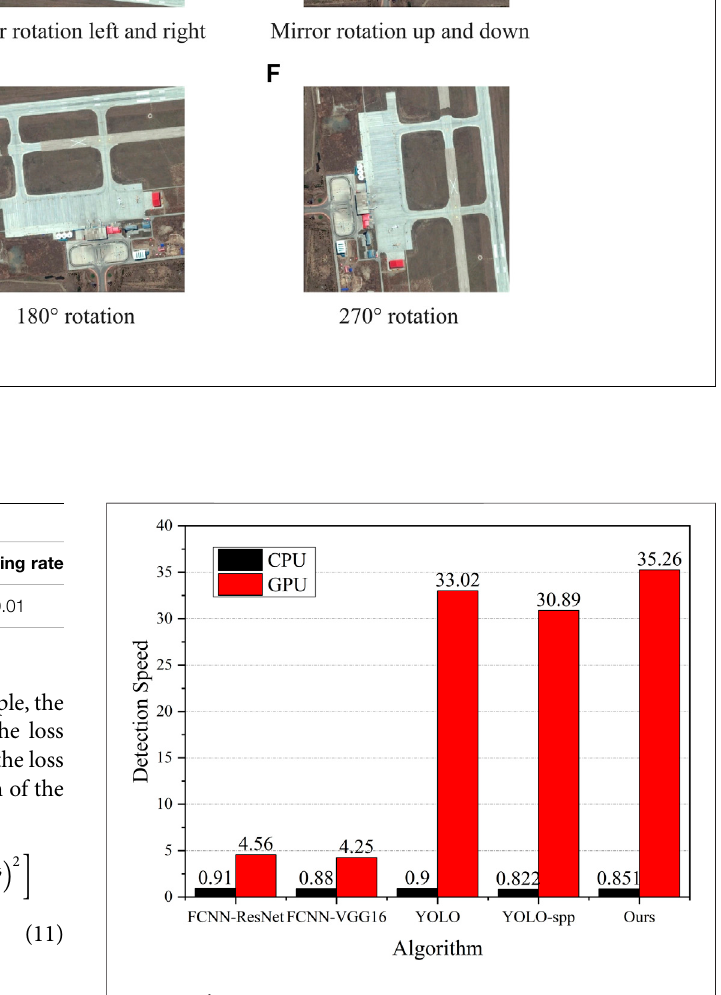
FIGURE 7 | Comparison of detection